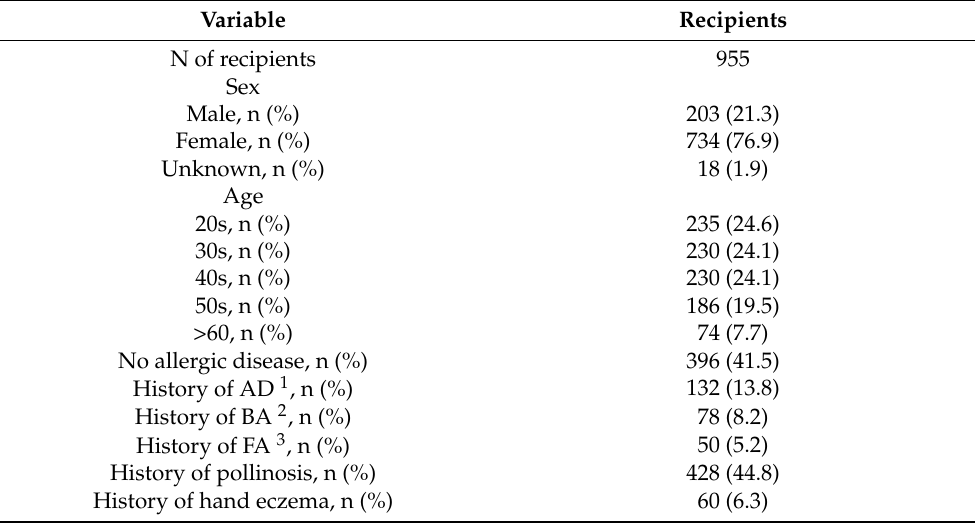
Table 1. Characteristics of participants in this